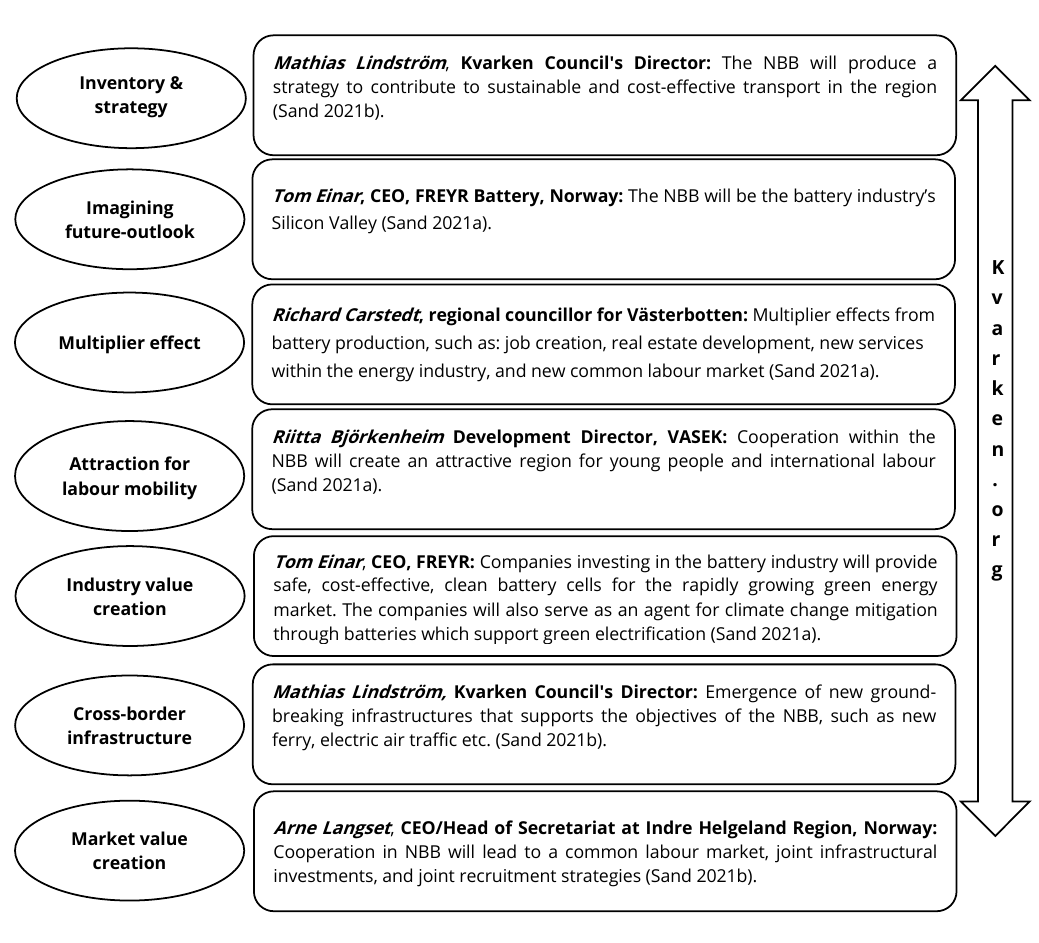
Fig. 2. The perspective of key stakeholders on battery production and the NBB. FFiigguurree 22:: TThhee ppeerrssppeeccttiivvee ooff kkeeyy ssttaakkeehhoollddeerrss oonn bbaatttteerryy pprroodduuccttiioonn && tthhee NNBBBB